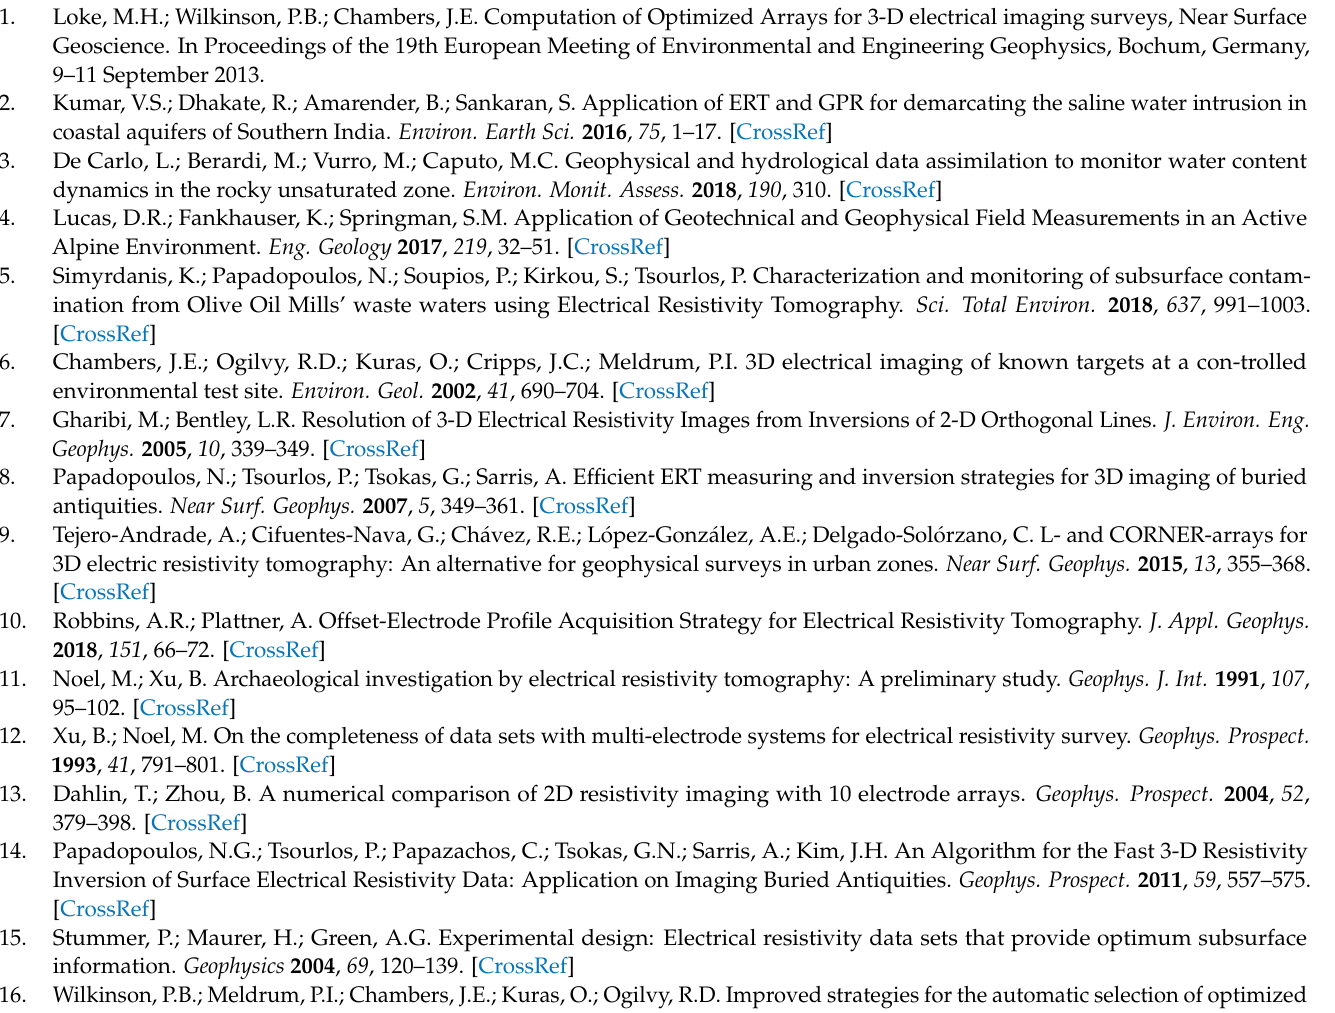
(cid:19) (cid:21) (cid:20)(cid:18) ( e ) ( e ) ∂ V ( e ) m ∂ V ( e ) m ∂ V ( e ) m ∂ V ( e ) n + ∂ V + ∂ V = dxdydz n n ∂ x ∂ x ∂ y ∂ y ∂ z ∂ z (cid:116) ∂σ ( e ) e .